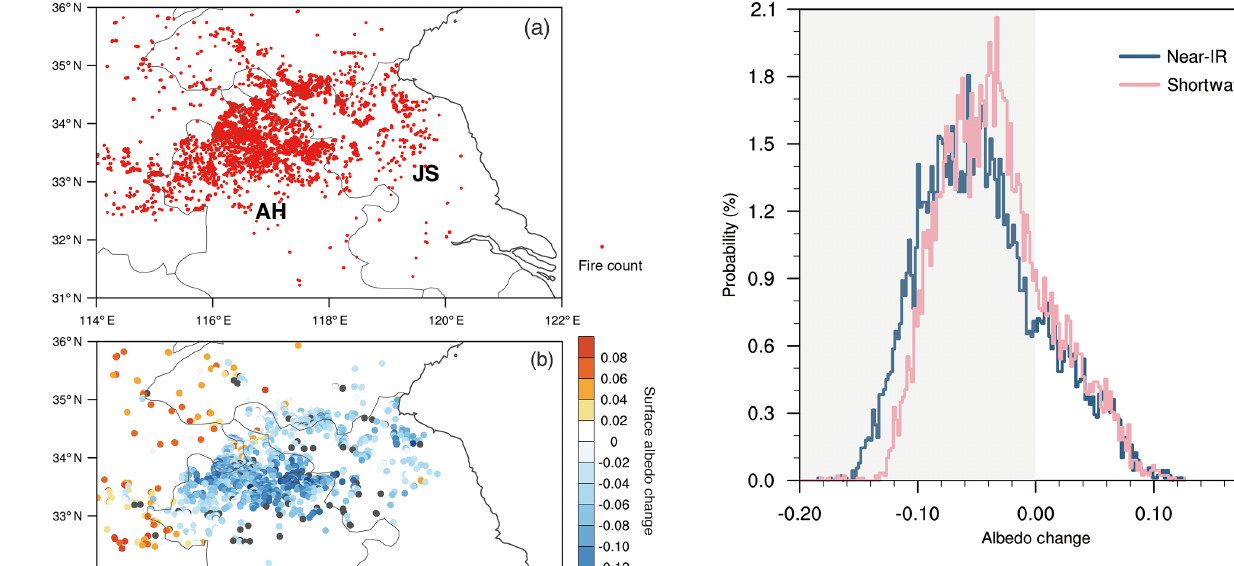
Figure 3. Frequency distributions of satellite-retrieved surface albedo changes in all pixels with highly confident satellite fire counts. Changes equal values on 17 June minus those on 24 May. The wavelength ranges of broadband “near IR” and “shortwave” are 0.7–2.5µm and 0.25–2.5µm,